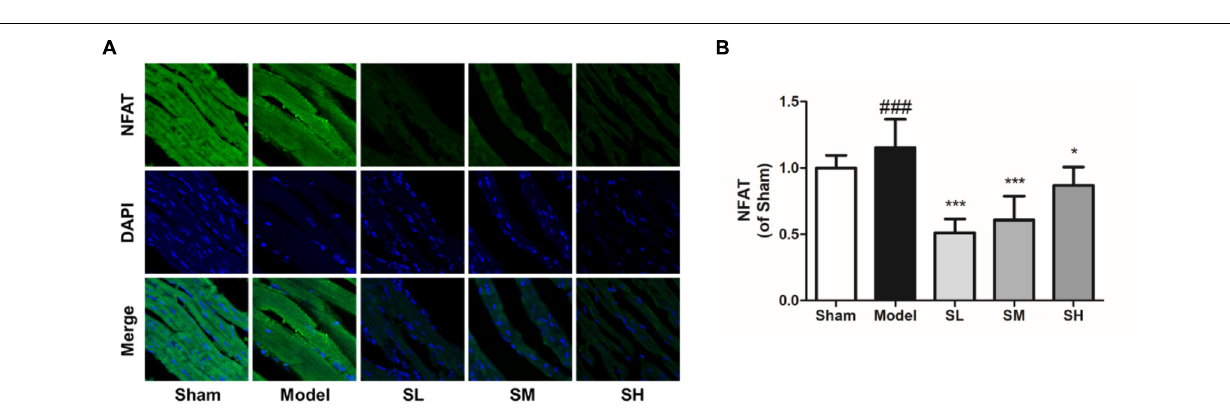
FIGURE 12 | The immunofluorescence of NFAT in the heart tissue after the treatment of Schisandra . (A) The immunofluorescence staining of NFAT in heart tissue (400 × ); (B) The quantitation of NFAT from immunofluorescence staining results. All data are shown as the mean ± SD, ### P < 0.001 vs. Sham group; ∗ P < 0.05, ∗∗∗ P < 0.001 vs. Model